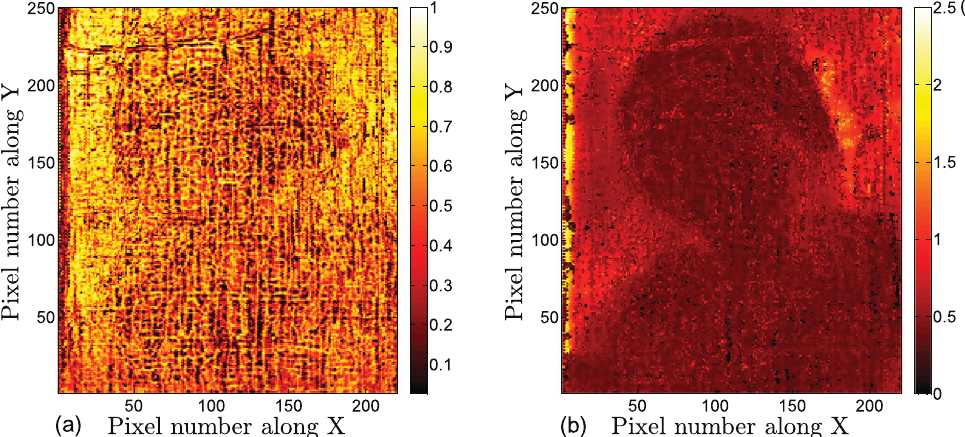
Figure 6. Varnish features revealed by THz sparsity-based deconvolved signals. ( a ) THz C-scan based on the amplitude of the first peak of the deconvolved signal. The contrast is normalized to one; ( b ) THz C-scan based on the optical delay between the first and second peaks of the deconvolved signal.